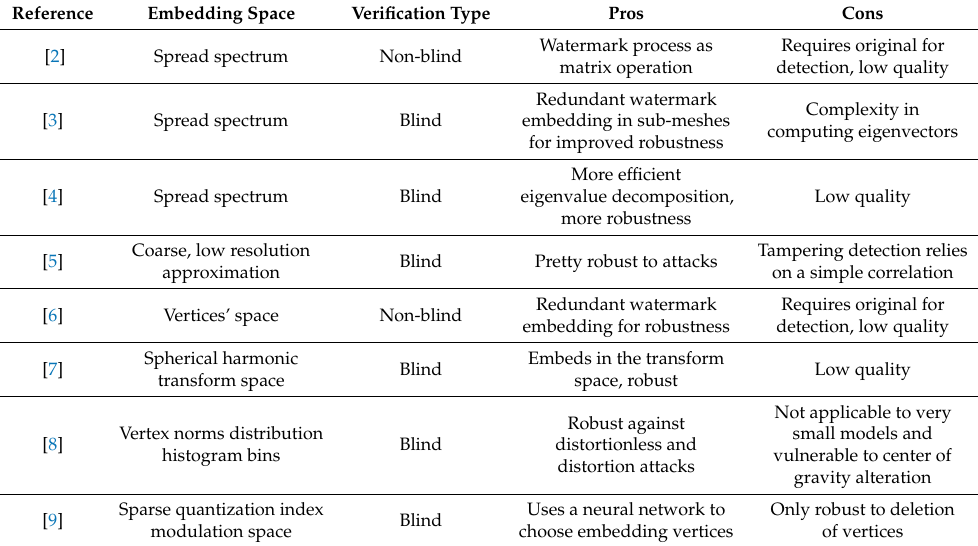
Table 1. Summary of related works on robust watermarking: main properties, pros, and cons.